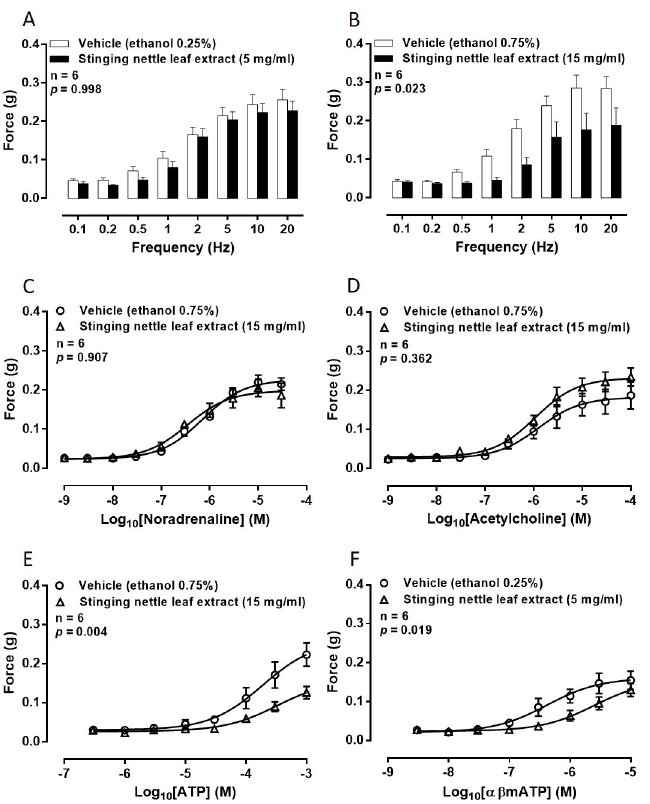
Fig 1. Effect of stinging nettle leaf extract on prostate smooth muscle contractility. Mean contractile responses to electrical field stimulation (0.5 ms, 60 V, 0.1 Hz to 20 Hz for 10 pulses or 10 seconds) of isolated rat prostate